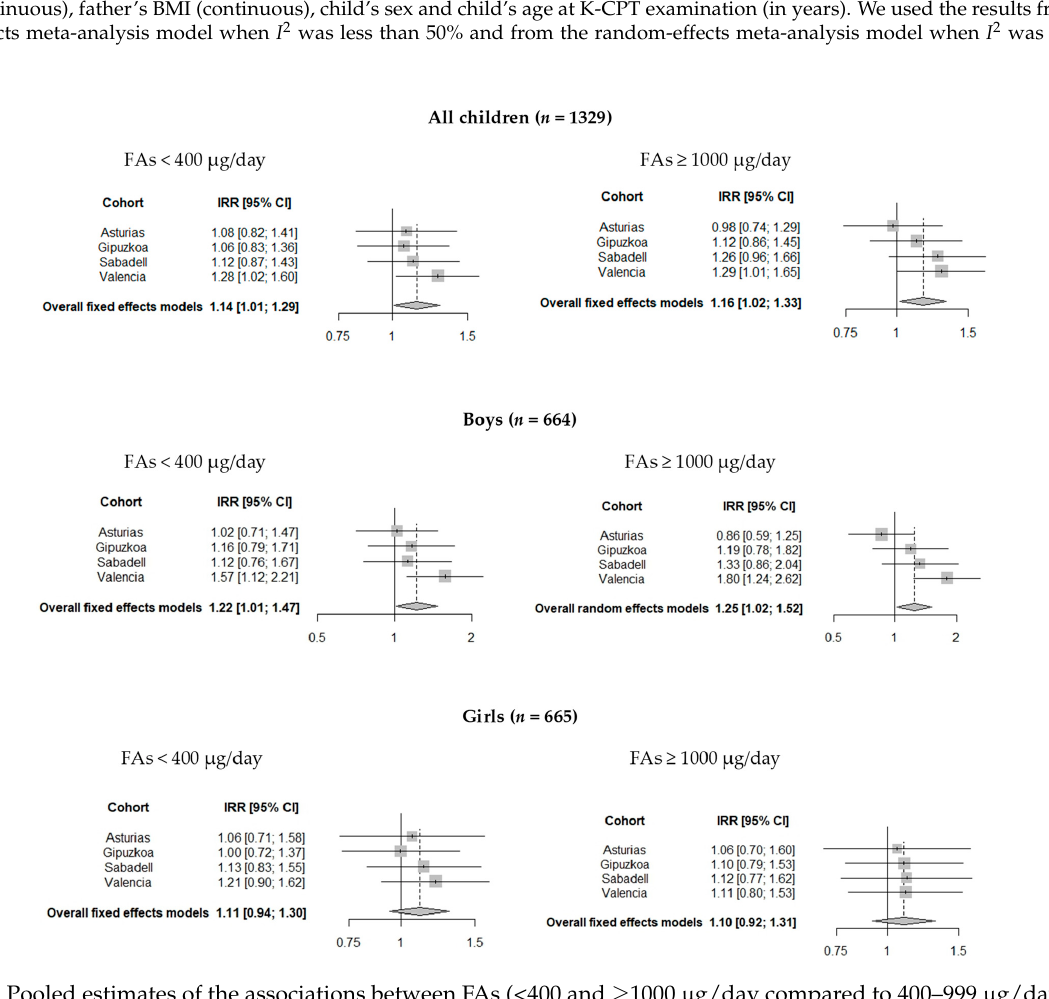
Figure 2. Pooled estimates of the associations between FAs (<400 and ≥ 1000 µ g/day compared to 400–999 µ g/day) and number of omission errors during periconceptional period of pregnancy in all children, boys, and girls at 4–5 years of age. When the analysis was stratified by sex, the positive association found between periconceptional FAs use of <400 μ g/d and the increased number of omission errors was only observed in boys (IRR = 1.22; 95% CI = 1.01 to 1.47), this FAs use was also associated with a higher HRT in boys ( β = 34.36; 95% CI = 10.01 to 58.71) (Figure 2). In addition, the periconceptional FAs use of ≥ 1000 μ g/day was associated with a higher HRT in boys ( β = 33.18; 95% CI = 6.10 to 60.25) and a higher HRT (SE) ( β = 3.31; 95% CI = 0.53 to 6.09). In girls, we only observed a protective association between the FAs use of <400 μ g/day dur- ing the second period of pregnancy and decreased number of omission errors (IRR = 0.86; 95% CI = 0.74 to 1.00) (Table 3). The combined associations between non-recommended FAs doses and boys’ and girls’ attentional function outcomes were similar to those ob- served by cohort. Omission errors and HRT(SE) associations found in boys were slightly higher and reached statistical significance only in the Valencia area, whereas the HRT as- sociation found in boys reached statistical significance only in the Gipuzkoa area (Figure 3). Table 3. Fully-adjusted combined association between FAs use during pregnancy and attentional function outcomes in children aged 4–5 years of the INMA cohort study according to sex; Spain, 2003–2008 ( n boys=664; n girls = 665).